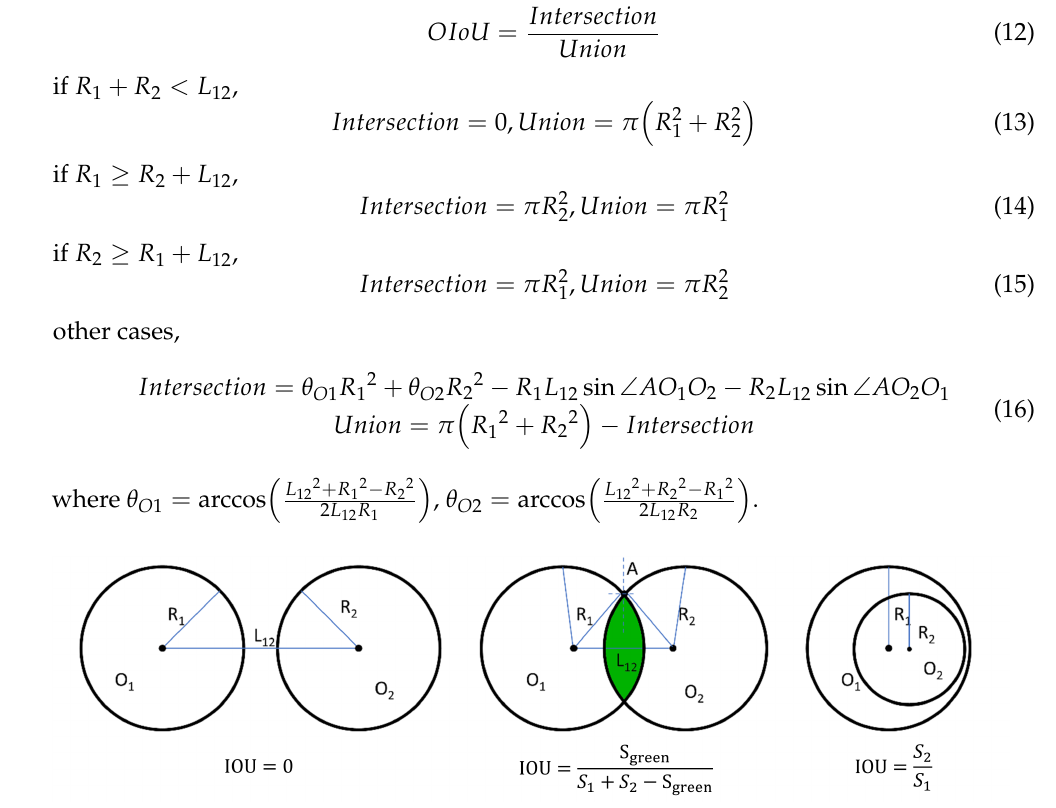
Figure 9. Several situations of the